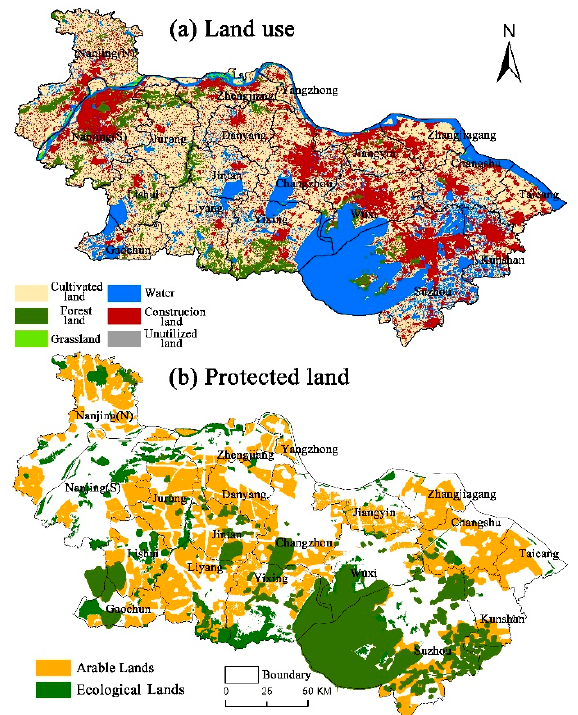
Figure 3. Land use ( a ) and spatial distribution of arable and ecological lands ( b ).